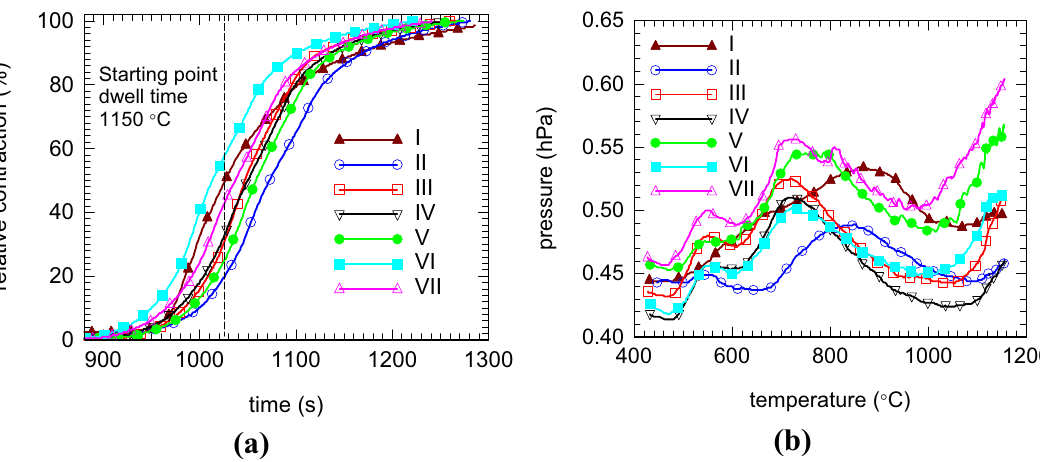
Figure 2. The evolution of the relative contraction with time ( a ), and the pressure in the SPS furnace as a function of temperature ( b ) for samples I–VII during the SPS processing.